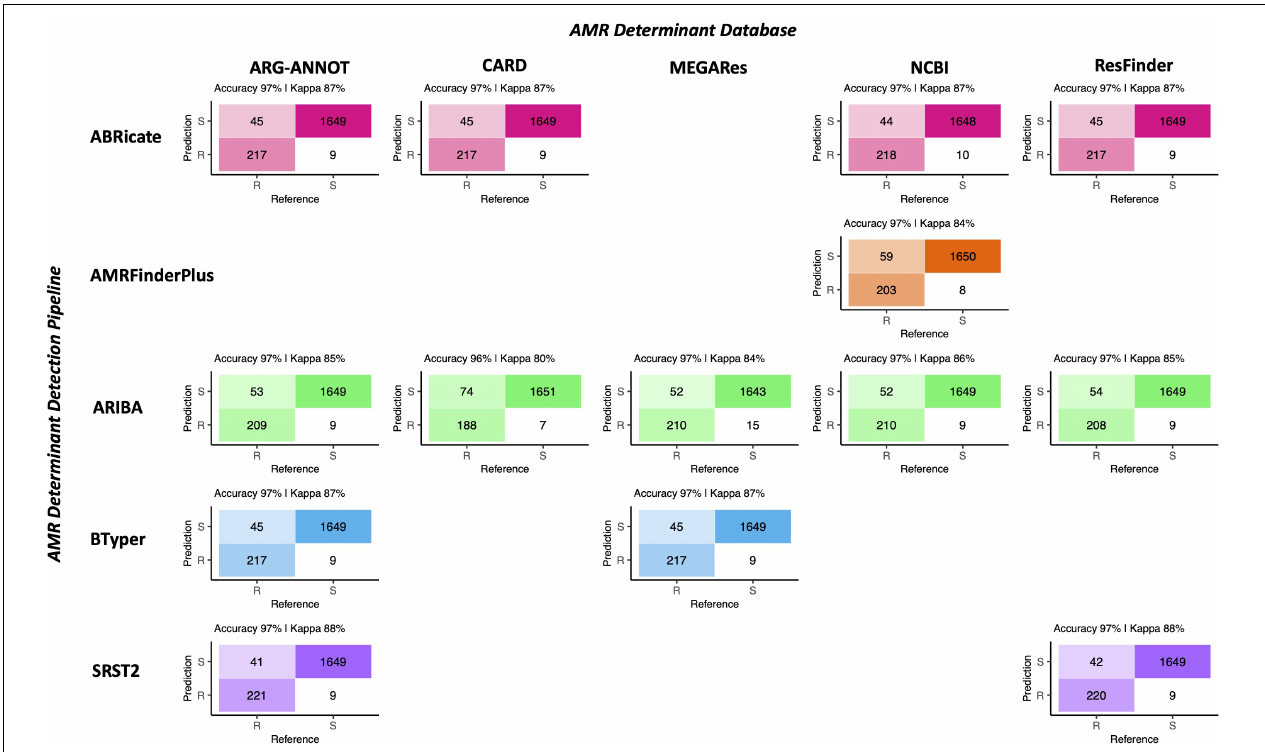
FIGURE 2 | Confusion matrices showcasing agreement between susceptible-intermediate-resistant (SIR) classification of 128 Salmonella isolates obtained using phenotypic resistance testing (denoted as the matrix “Reference”) and five in silico methods (denoted as the matrix “Prediction”) for 15 antimicrobials. Accuracy values above each matrix denote the percentage of correctly classified instances out of all instances. Kappa values above each matrix denote Cohen’s kappa coefficient for the matrix, reported as a percent. For the phenotypic method, SIR classification was determined using NARMS breakpoints for Salmonella (accessed March 23, 2020). For the in silico antimicrobial resistance (AMR) determinant detection approaches, combinations of five pipelines and one to five AMR determinant databases were tested; isolate genomes that harbored one or more AMR determinants previously known to confer resistance to a particular antimicrobial were categorized as resistant to that antimicrobial (“R”), while those which did not were categorized as susceptible (“S”; see Supplementary Table 2 for all detected AMR determinants and their associated resistance classifications). For all AMR determinant detection methods, isolates that showed intermediate phenotypic resistance to an antimicrobial were categorized as susceptible (“S”) rather than resistant, as this classification produced slightly better accuracy scores for all pipeline/database combinations. For AMR determinant detection methods that relied on nucleotide BLAST (i.e., ABRicate and BTyper), the confusion matrix obtained using the nucleotide identity and coverage threshold combination that produced the highest accuracy are shown ( Supplementary Figure 3 ); for all other methods, confusion matrices obtained using default detection parameters are shown.